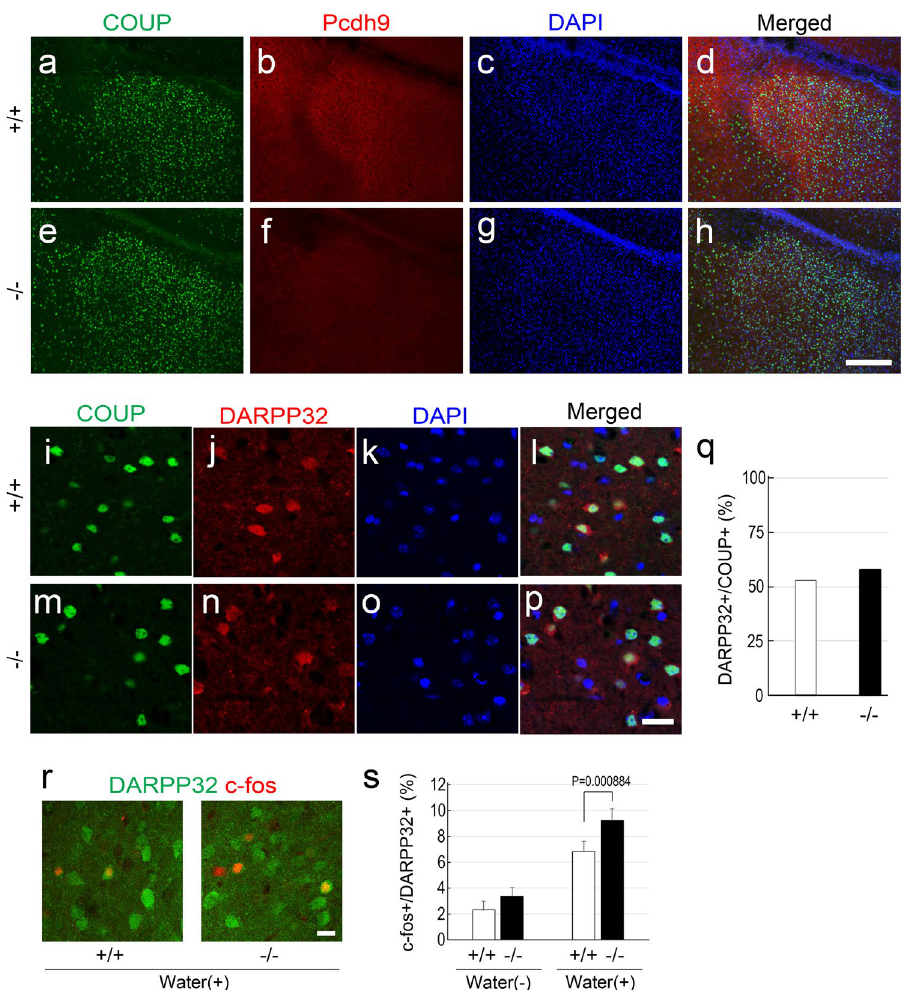
Figure 4. pBLA in the Pcdh9 KO mice. ( a – h ) The size of pBLA, visualized with a marker of BLA neurons (COUP-TFII), was not affected in the KO mice. ( i – p ) Double staining of COUP-TFII and DARPP-32 ( Ppp1r1b ), a marker of fear extinction neurons. ( q ) The number of DARPP-32 + neurons was not changed in the pBLA of the KO mice. ( r ) Double staining of c-fos (red) and DARPP32 (green) after a water reward. ( s ) c-fos expression in the DARPP-32 + neurons was not different between the wt mice and the Pcdh9 KO mice without a water reward, whereas it was significantly higher in the Pcdh9 KO mice than that of the wt mice after a water reward. In the case without water reward, the numbers of c-fos + and DARPP-32 + were counted with 10 sections from two wt mice and 12 sections from two Pcdh9 KO mice, whereas in the case with water reward, the numbers of c-fos + and DARPP-32 + were counted with 28 sections from five wt mice and 30 sections from six Pcdh9 KO mice. Scale bars, 200 μm in ( a – h ) and 20 μm in ( i – p , r